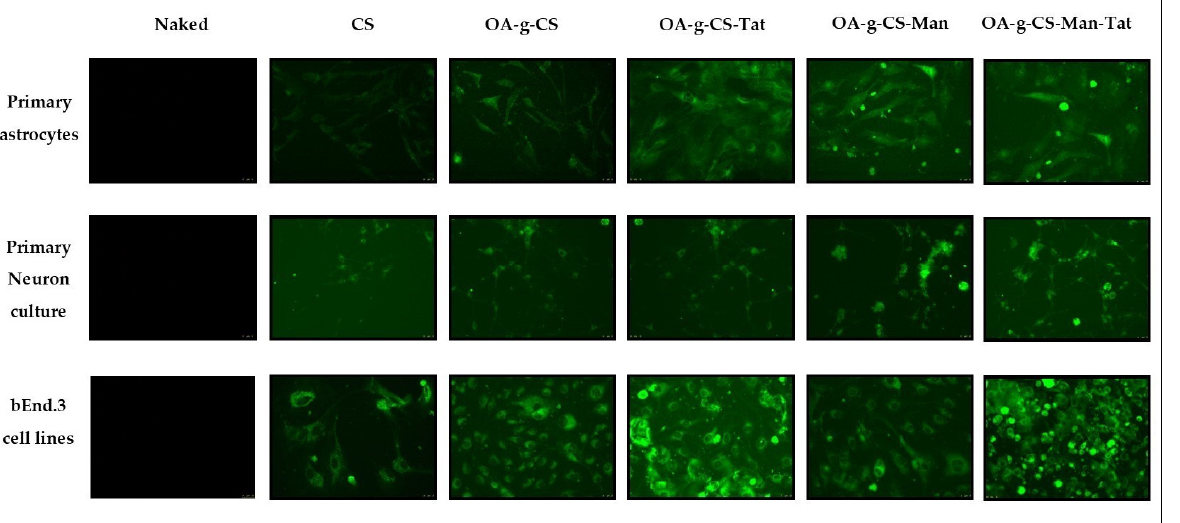
Figure 7. In vitro cytocompatibility of CS, OA-g-CS, OA-g-CS-Man, OA-g-CS-Tat, and OA-g-CS- Man-Tat polymeric micelles at different concentrations (0.125–1000 µg/mL) in bEnd.3 cells. MTT was used to evaluate cell viability, data presented as mean ± SD (n = 4).